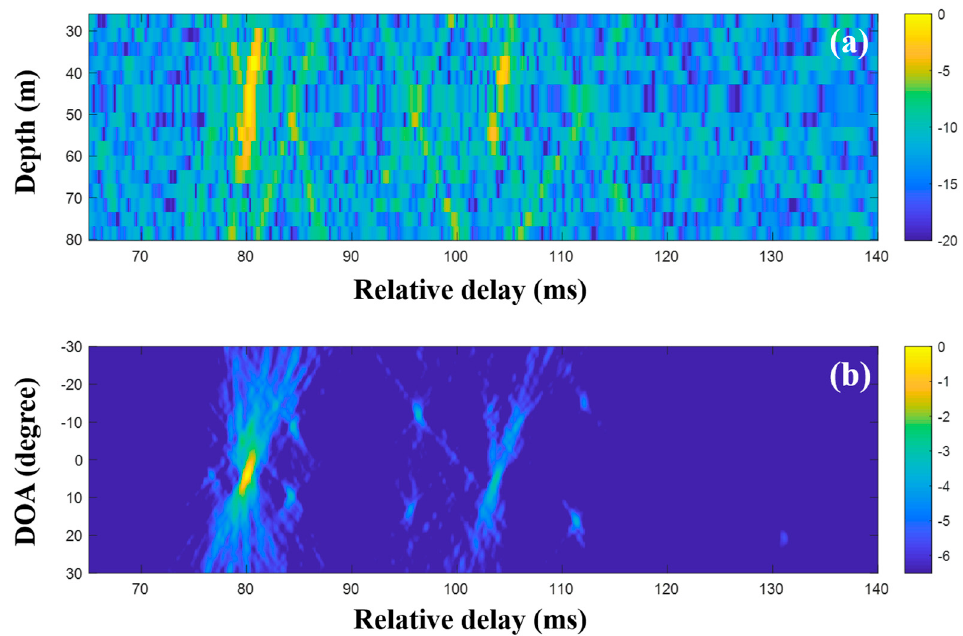
Figure 11. Direction-of-arrival (DOA) estimation using the matched filter (MF) with a single snapshot captured by the vertical line array (VLA) in SAVEX15 (0.5–2 kHz): ( a ) arrival structures via the application of the MF to the signals at the VLA and ( b ) DOAs using delay-and-sum beamforming with the arrival structures.